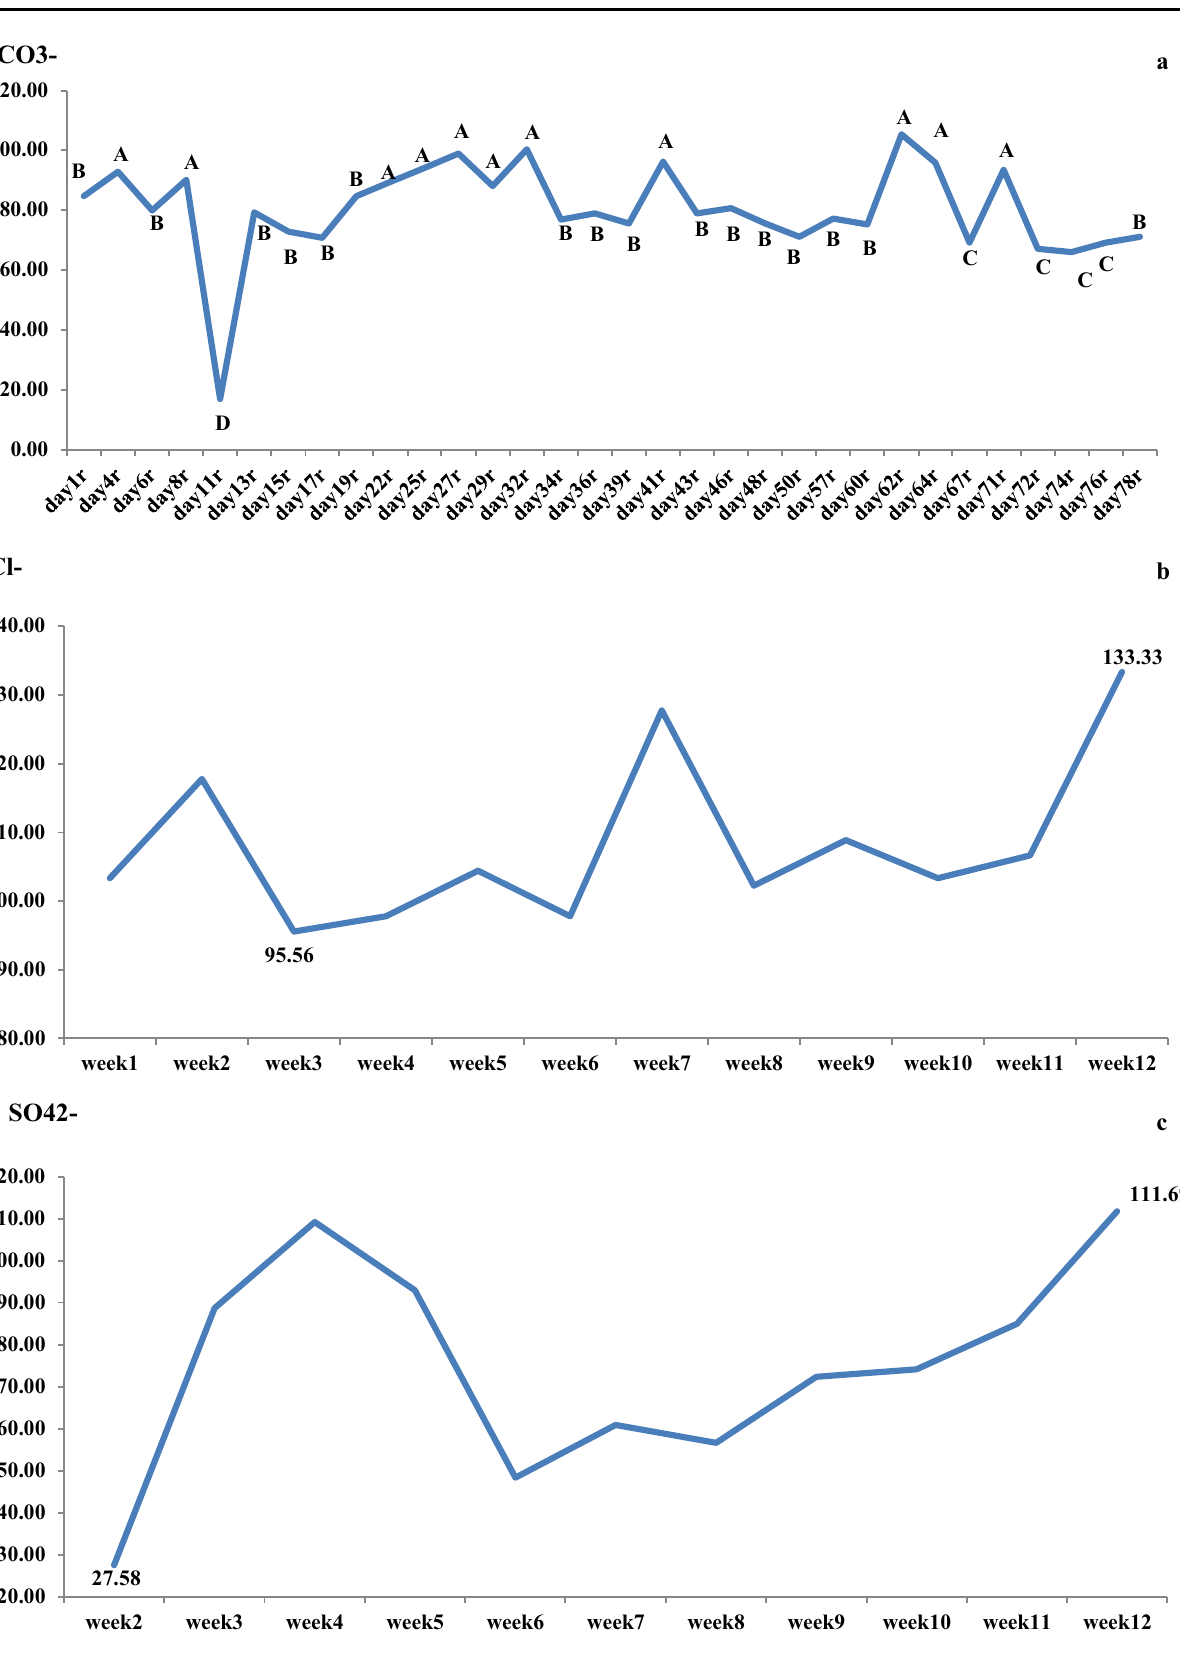
Fig. 2 Average effect of time on Anions in (a, b and c) and Cations in (d and